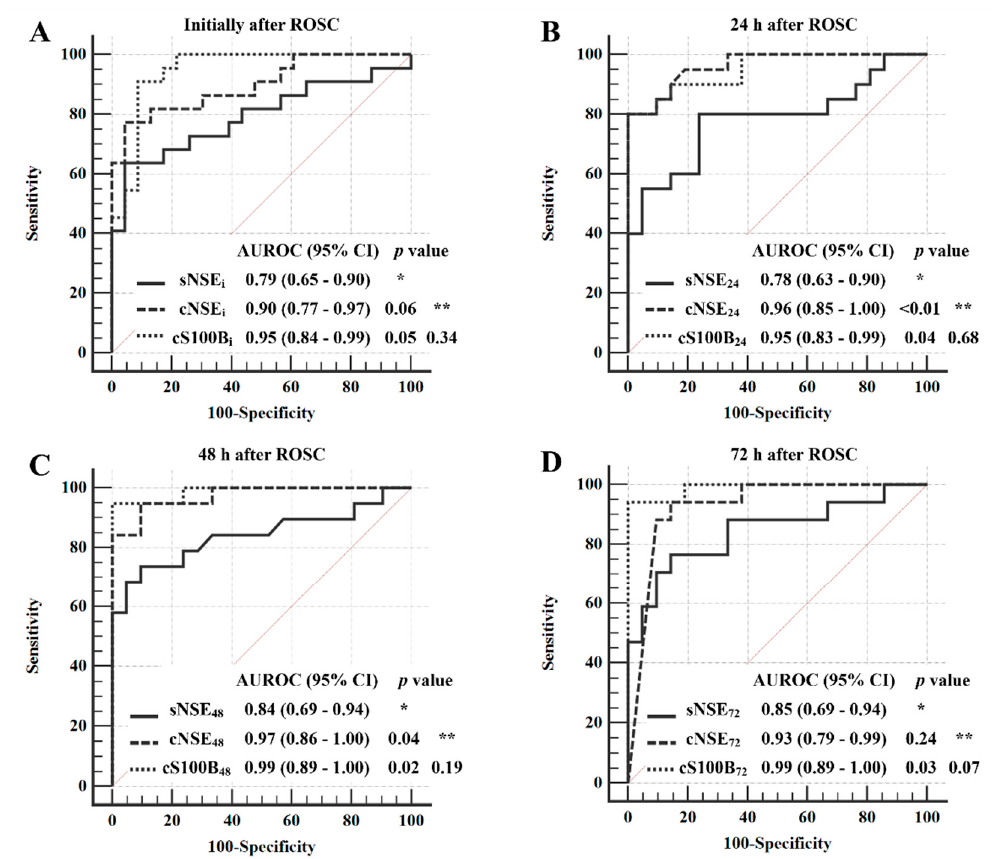
Figure 3. Statistical analysis of the area under the receiver operating characteristic curves of serum and cerebrospinal fluid neuron-specific enolase, and cerebrospinal fluid S100B concentrations measured ( A ) immediately and at ( B ) 24, ( C ) 48, and ( D ) 72 h after the return of spontaneous circulation. References for the DeLong test for statistical comparison between (*) serum NSE and CSF biomarkers and (**) CSF NSE and S100B. CI, confidence interval; NSE, serum and cerebrospinal fluid neuron-specific enolase concentration measured immediately (sNSE i and cNSE i ) and at 24 (sNSE 24 and cNSE 24 ), 48 (sNSE 48 and cNSE 48 ), and 72 h (sNSE 72 and cNSE 72 ) after the return of spontaneous circulation; S100B, cerebrospinal fluid S100B protein concentration measured immediately (cS100B i ) and at 24 (cS100B 24 ), 48 (cS100B 48 ), and 72 h (cS100B 72 ) after the return of spontaneous Table 3. Prognostic accuracies of NSE and S100B obtained from CSF for poor neurological outcome. Values Cut-off